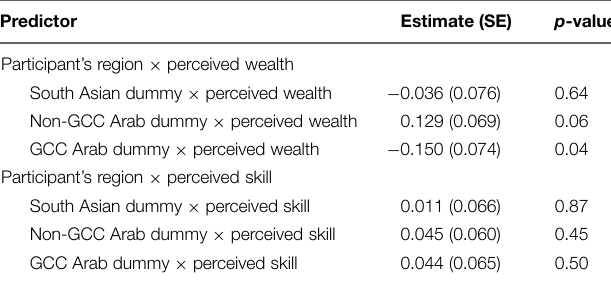
TABLE 6 | Interaction coefficients from model testing the moderating effects of the participant’s region. Predictor